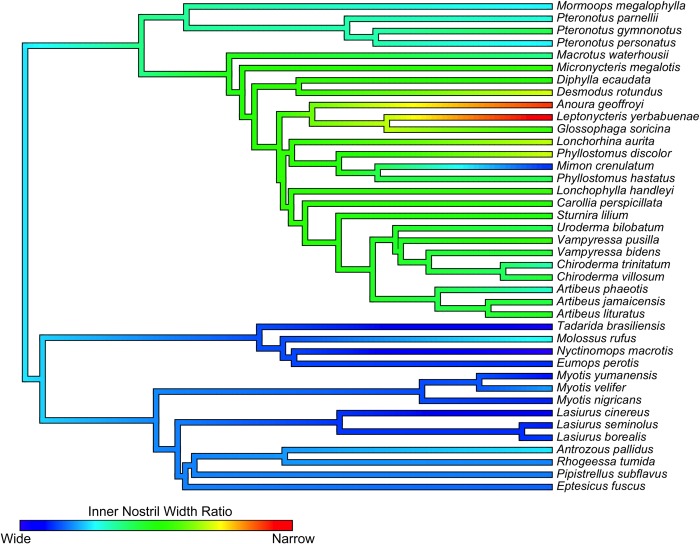
Ancestral character estimation of inner nostril width ratio (INWR).Red colors indicate species with narrow nostrils relative to head width, while dark blue indicates species with relatively wide nostrils. Illustration made in R (contMap function, package phytools;[47]).